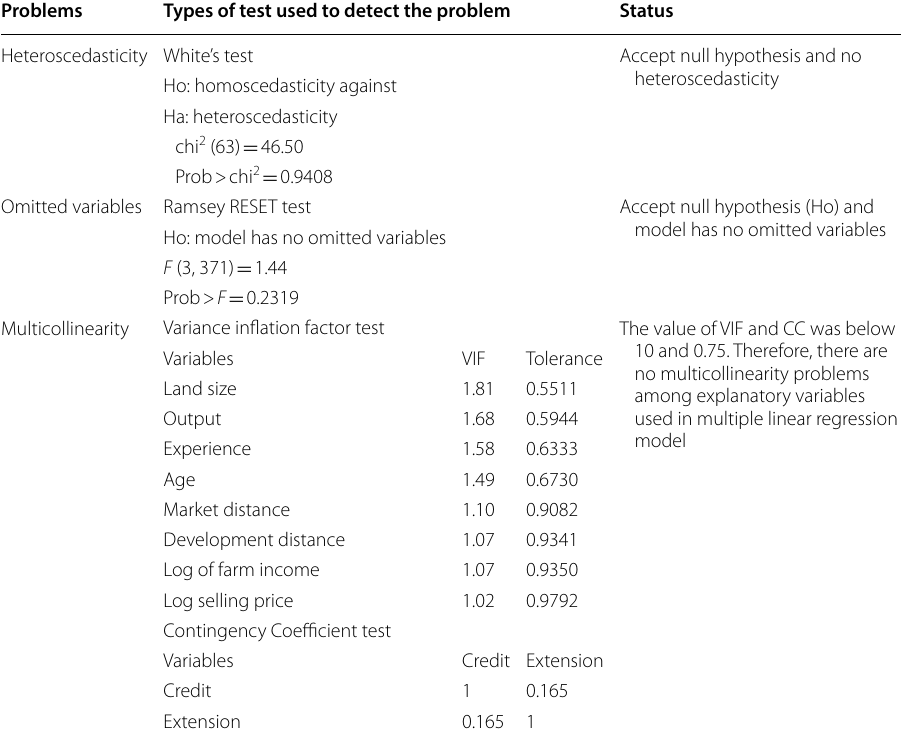
Table 2 Post-estimation tests of multiple linear regression model Problems